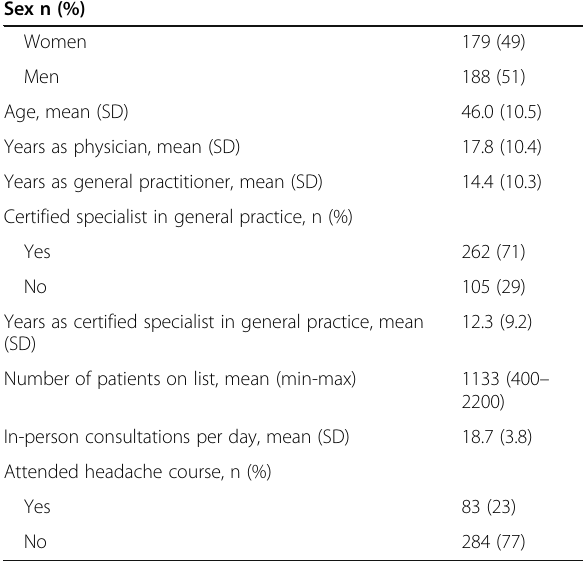
Table 1 Descriptive data of the participants ( N = 367)